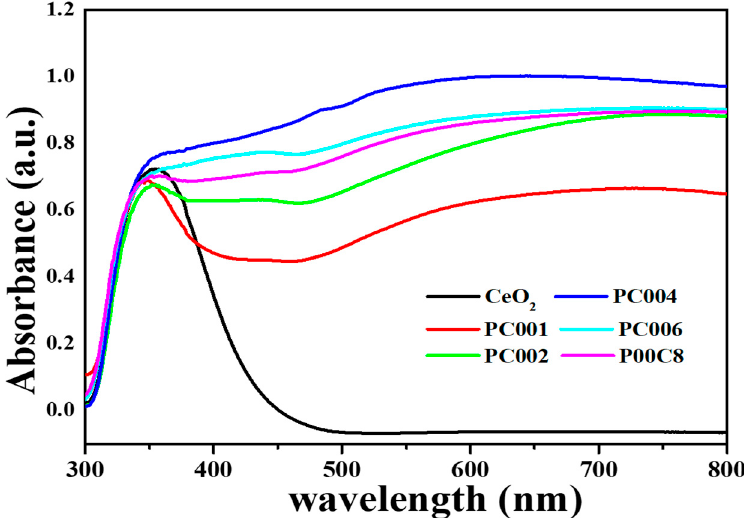
Figure 5. UV-Vis curve of the CeO 2 / PANI powders as a function of the amount of PANI coating.